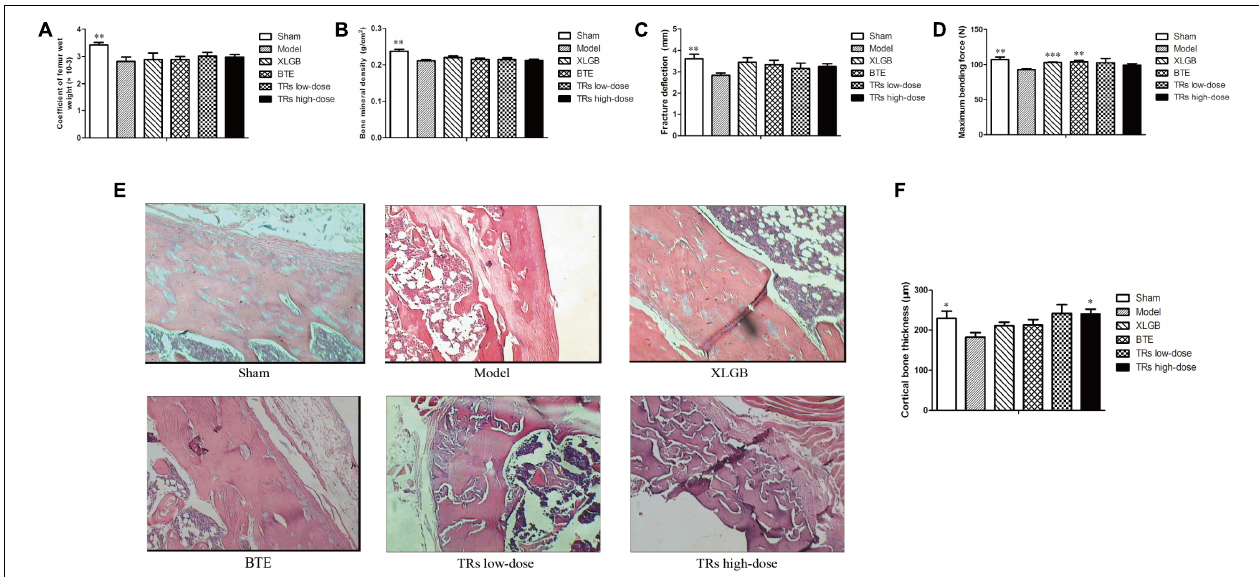
FIGURE 2 | The effect of black tea extract (BTE) and thearubigins (TRs) on bone quality in ovariectomized (OVX) rats. (A) Femur wet weight coefficient, (B) bone mineral density, (C) femoral fracture deflection, (D) maximum bending force for each treatment group. (E) The cortical bone tissue was examined by hematoxylin and eosin (H&E) staining (magnification × 400) and (F) cortical bone thickness counts, statistical analysis. All data are presented as mean ± SEM ( n = 10). “Independent Samples T-Test” and “One way ANOVA” were used for the comparison of sham vs model group and model vs treatment groups using pooled variance, respectively.